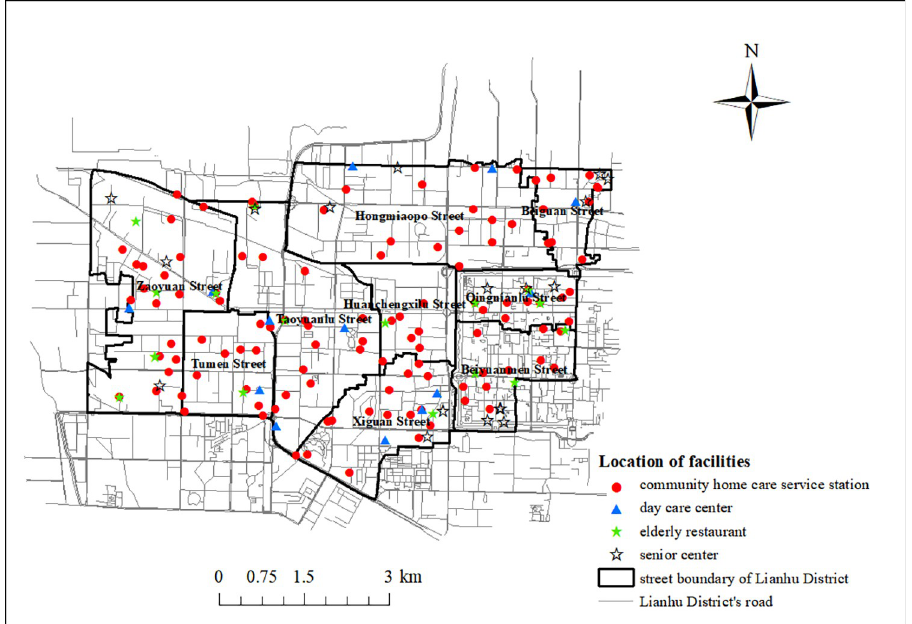
Fig 3. Spatial distribution of community home care facilities. (https://www.openstreetmap.org/relation/3226093).